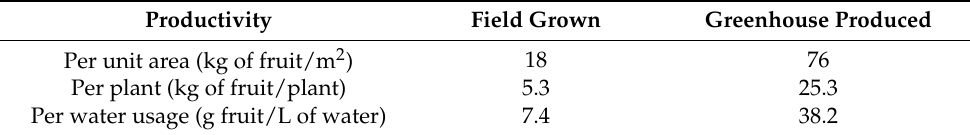
Figure 1. Comparison of the Australian global import and export markets of processed tomato fruits (tonnes of product). Most tomato imports come from Italy, USA and China. The tomato export market primarily consists of smaller countries geographically close to Australia such as New Zealand, Japan, Vietnam and Thailand. Data were sourced from a 2017 report [30]. Table 1. A comparison by Protected Cropping Australia on the production statistics between field and greenhouse tomato production in the Australian fresh fruit market industry. In all instances, green- house production is an order of magnitude (>400%) greater than field grown tomatoes, highlighting a high efficiency in greenhouse production